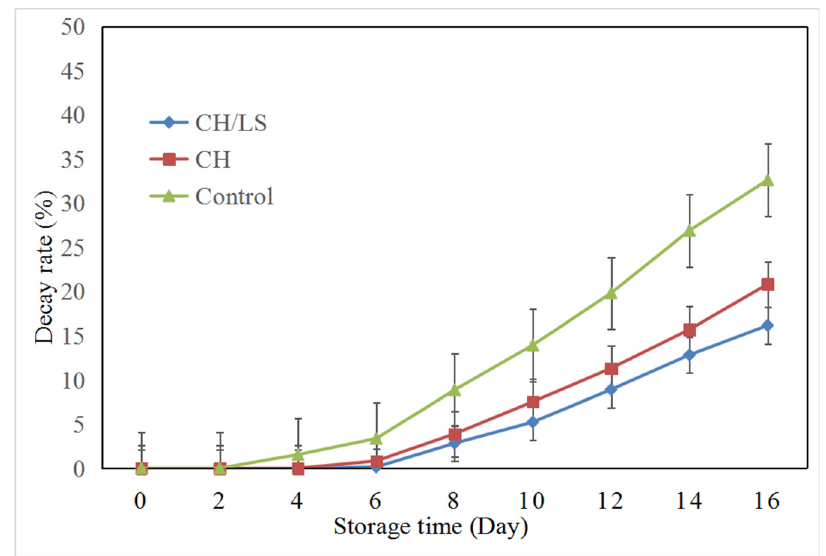
Figure 1. Decay rates of grapes during preservation with packaging films.